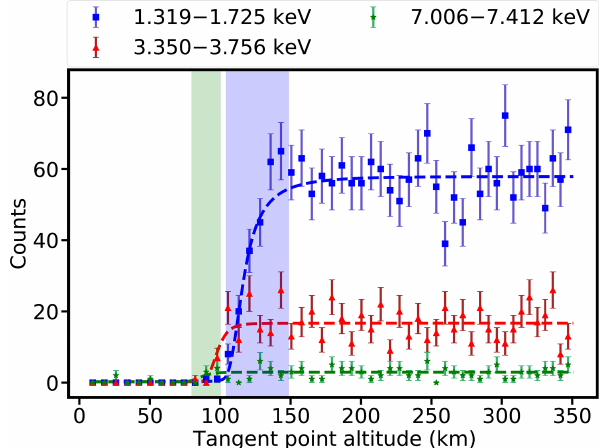
Figure 5. The light curves during the occultation process. The points with the error bars are observation data. The dashed blue, red, and green lines represent the modelled light curves. The green shaded region corresponds to the height range for the occultation in the energy bands of 7.006–7.412keV. The height range for occul- tation in the energy range of 7.006–7.412keV is about 85–100km. The blue shaded region corresponds to the height range for the oc- cultation in the energy bands of 1.319–1.725keV. The height range for occultation in the energy range of 1.319–1.725keV is about 102–150km. For clarity, the height range for occultation between 3.350 and 3.756keV is not marked. The height range for occulta- tion in the energy range of 3.350–3.756keV is about 90–110km. The reason for the relatively large variability of each light curve is the absorption of X-ray photons by atoms of atmospheric con-